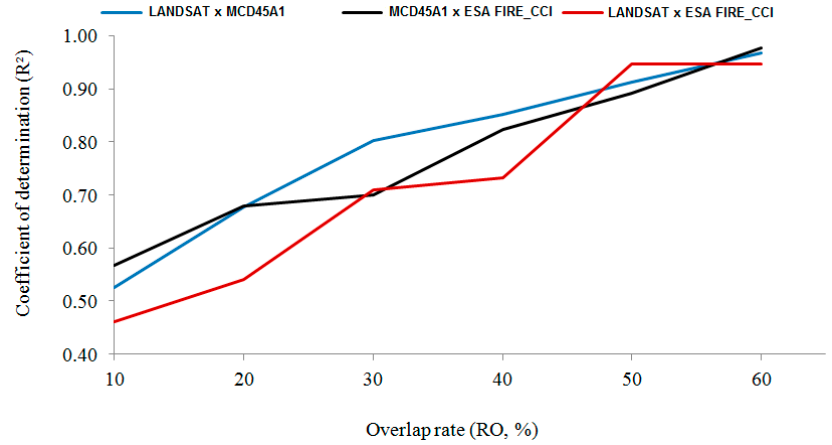
Figure 3. Coefficient of determination (R 2 ) obtained for the linear regression between overlapping patch areas, as a function of overlapping rate (OR, %) in each comparison: LANDSAT × MCD45A1, MCD45A1 × ESA FIRE_CCI and LANDSAT × ESA FIRE_CCI.